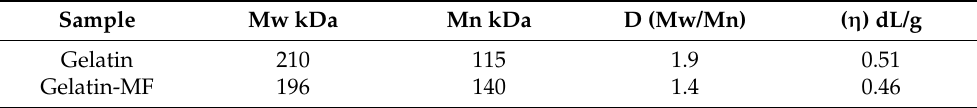
Table 1. Main results of the high-performance size exclusion chromatography on line with a triple detector array (HP-SEC-TDA) analysis for the gelatin and gelatin-methylfuran (MF) samples. Sample